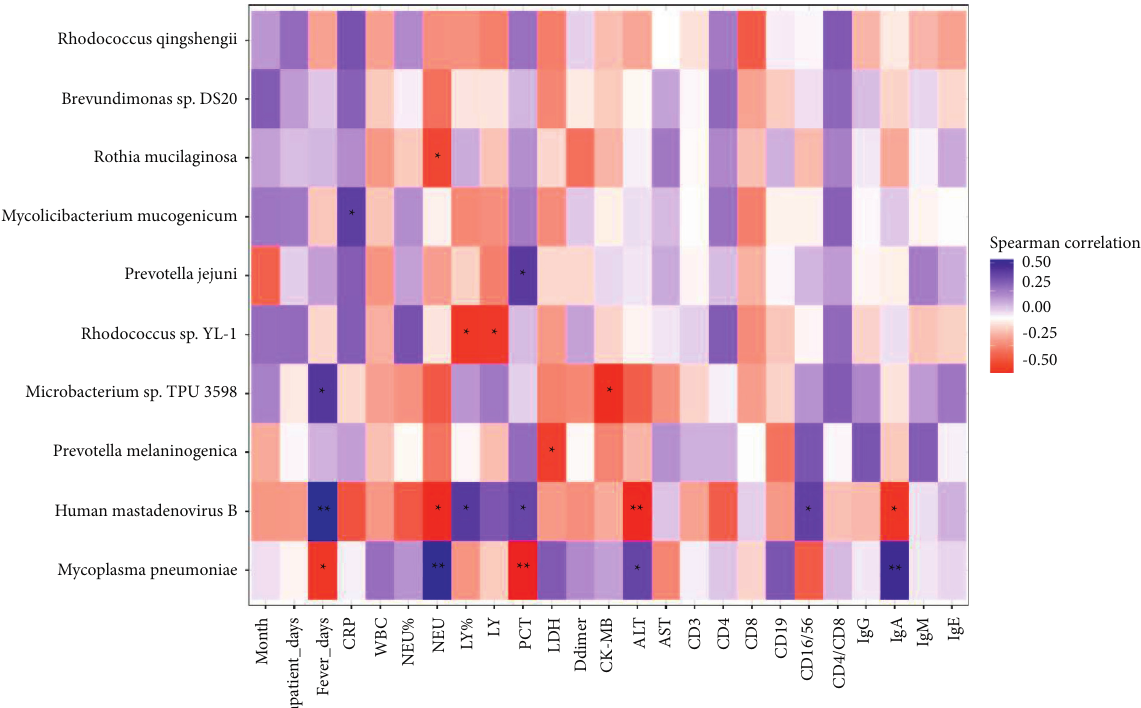
Figure 4: Heatmap of Spearman correlations between clinical measures and microbiota species. WBC, white blood cell counts; LY, lymphocyte count; LY%, lymphocyte percentage; Neu, neutrophil count; Neu%, neutrophil percentage; PCT, procalcitonin; CRP, C-reactive protein; LDH, lactate dehydrogenase; CK-MB, creatine kinase isoenzyme-MB; ALT, alanine aminotransferase; AST, aspartate amino- transferase. ∗ P < 0 . 05 and ∗∗ P < 0 .